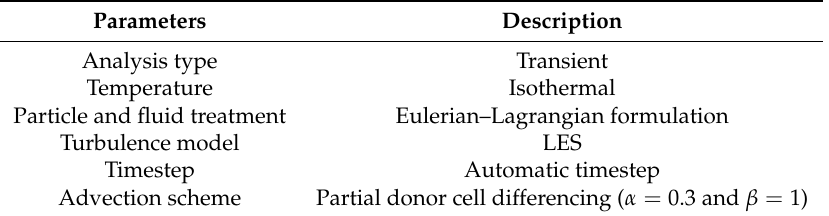
Table 1. Set-up for the CPFD.